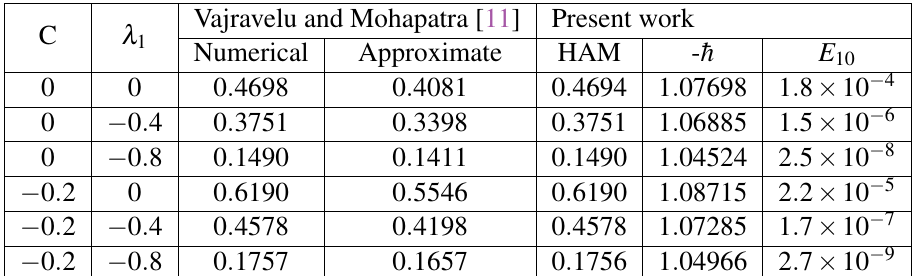
Table 1 Comparison of skin friction coefficient for different values of C and λ 1 in the absence of magnetic parameter Mn , first-order slip parameter γ , and second-order slip parameter δ .